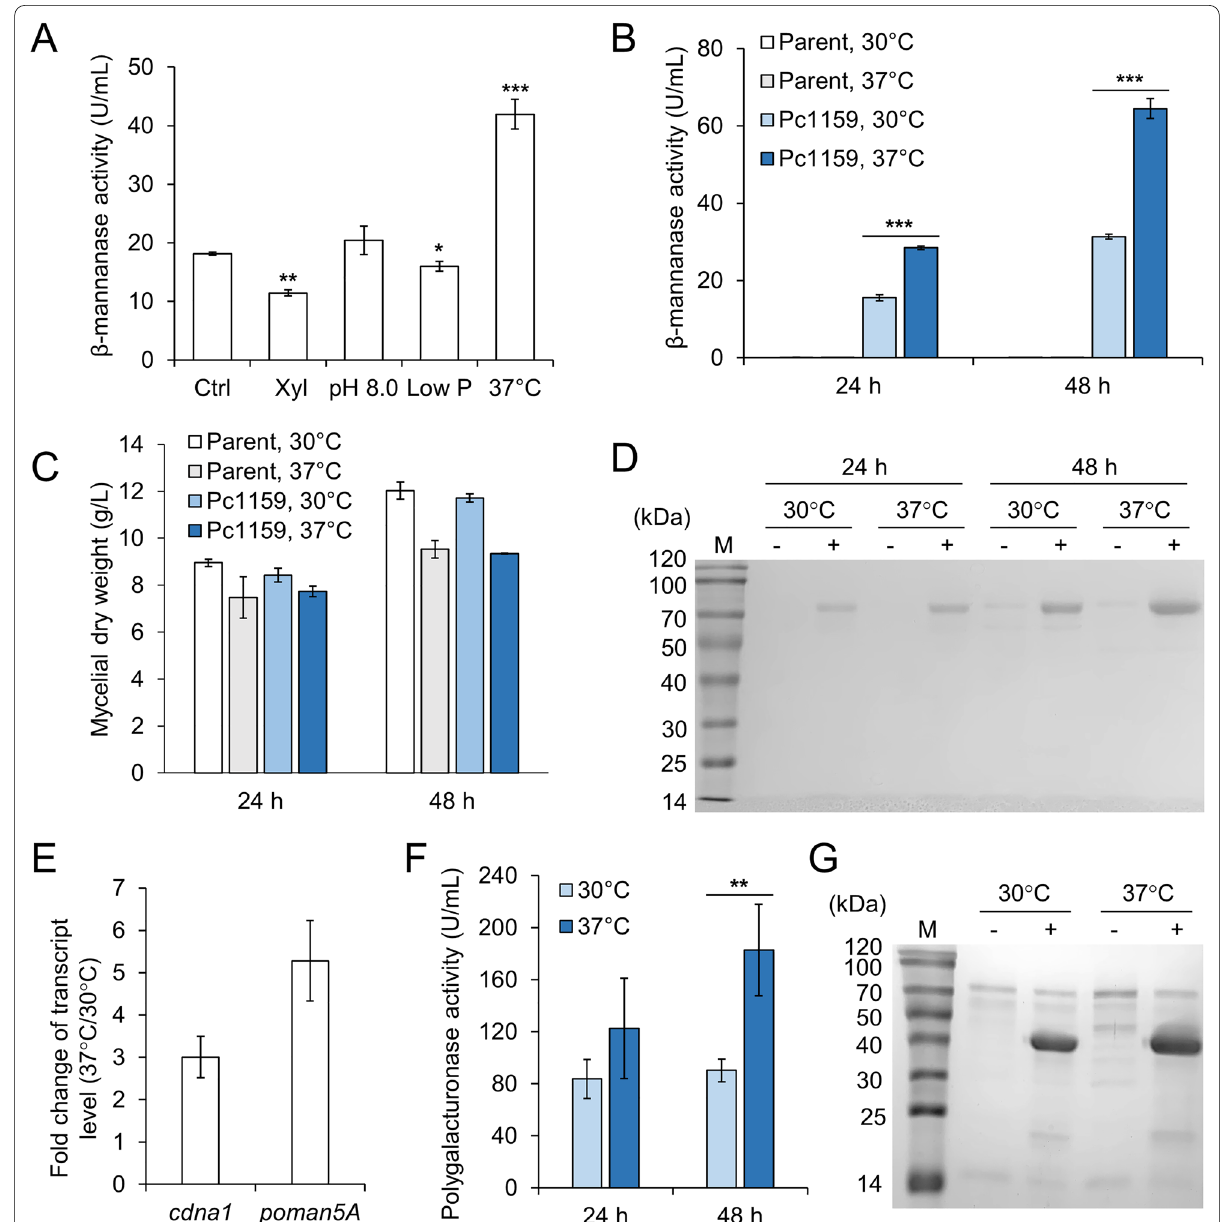
Fig. 3 The effect of temperature on protein expression driven by cdna1 promoter. A β-Mannanase production with Pc1159 promoter under different conditions. The samples were taken after 24 h of cultivation. Data represent mean SD from duplicate cultivations. Xyl, xylose. Low P, ± low phosphate. B The effect of temperature on β-mannanase production of the strain expressing poman5A with Pc1159. The parent strain was used as a control. C SDS-PAGE analysis of the culture supernatants analyzed in panel B. D The effect of temperature on cell growth. E The effect of temperature on the transcript abundances of cdna1 and poman5A in the strain expressing poman5A with Pc1159. RNA samples were taken at 24 h. F The effect of temperature on endopolygalacturonase production by the strain expressing popga with Pc1159. G SDS-PAGE analysis of the culture supernatants at 48 h analyzed in panel F . Data in panels B and D – F represent mean SD from triplicate cultivations. In panel A , the statistical ± significances of the difference between control and cultures under different conditions are shown. In panels B and F, the statistical significances of the difference between cultures at 30 °C and 37 °C are shown. *, P < 0.05; **, P < 0.01; ***, P <